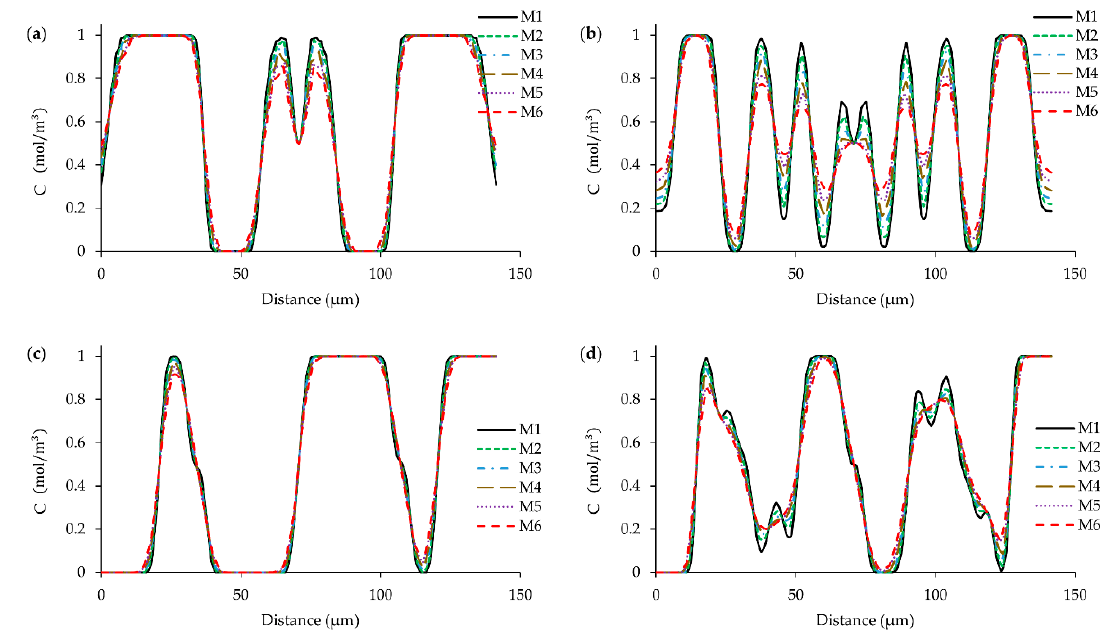
Figure 7. Grid study results for scalar transport at Re = 120: ( a ) and ( c ) concentration distribution on x-y plane at the exit of the mixing box (Line-I in Figure 3) for four-inlet and two-inlet designs respectively; ( b ) and ( d ) concentration distribution on x-y plane at z = 500 µ m (Line-II in Figure 3) for four-inlet and two-inlet designs respectively .